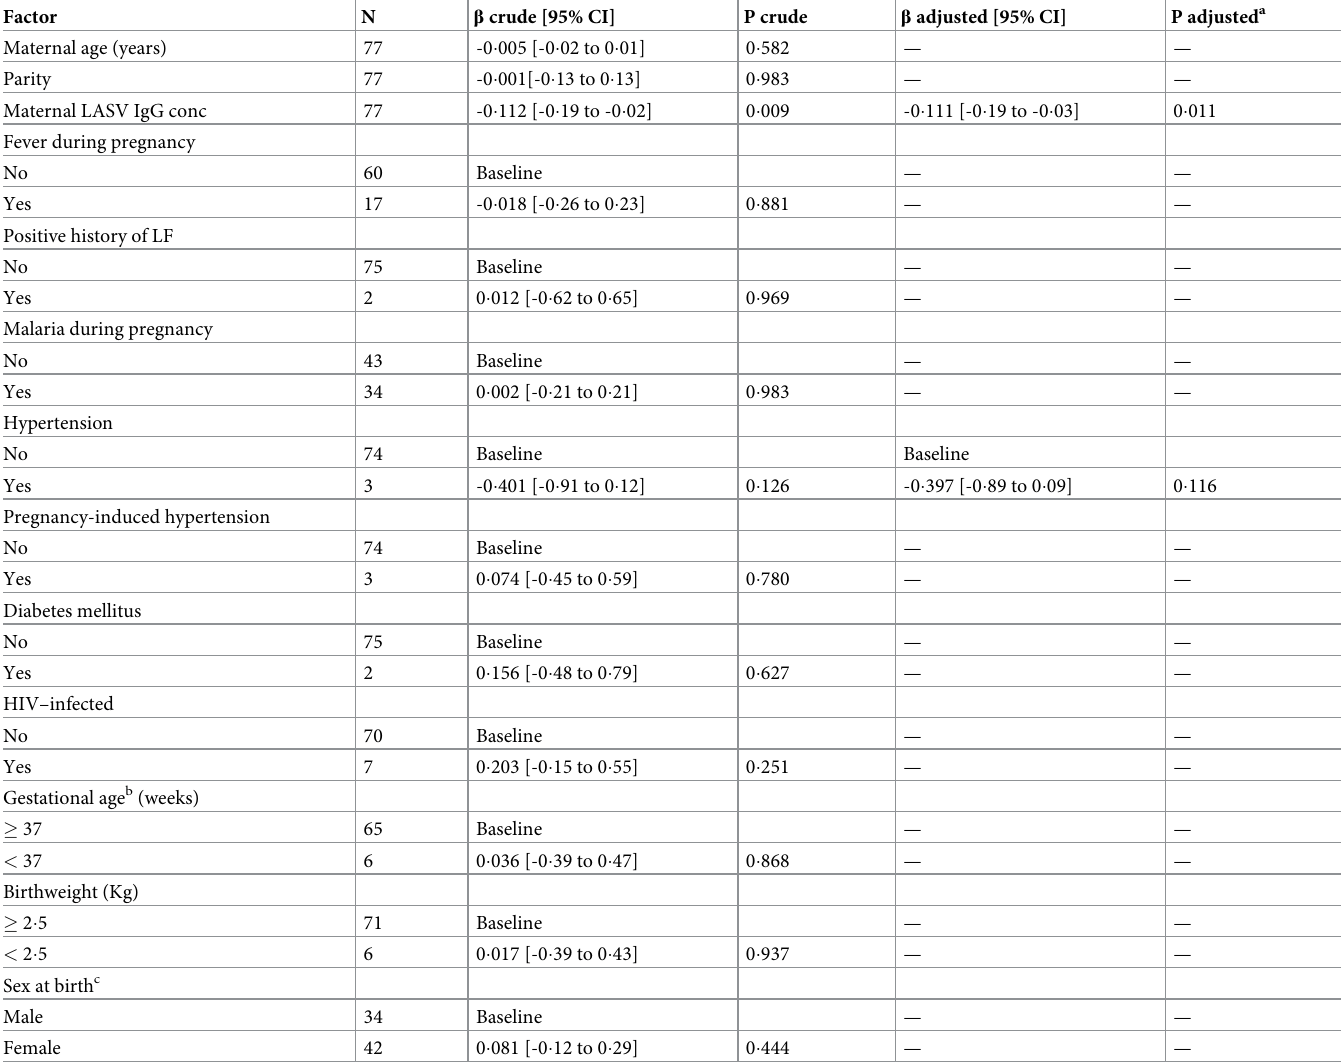
Note: β - regression coefficient showing change in LASV IgG CMR; CI- confidence interval; CMR- cord–maternal ratio; conc- concentration; IgG- immunoglobulin G; LASV- Lassa virus; LF- Lassa fever; N- total number of pregnant women included in analysis. a Adjusted for factors which were marginally significant in the univariate analysis (p < 0.25). b Based on Ballard’s score, data missing for 6 women. c Data missing for 1